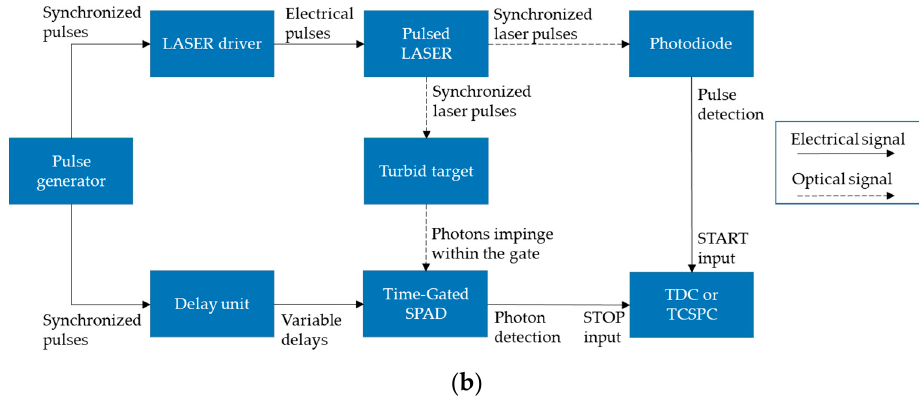
Figure 9. Components of TR-DOS prototypes using ( a ) FR detector, ( b ) TG detector.